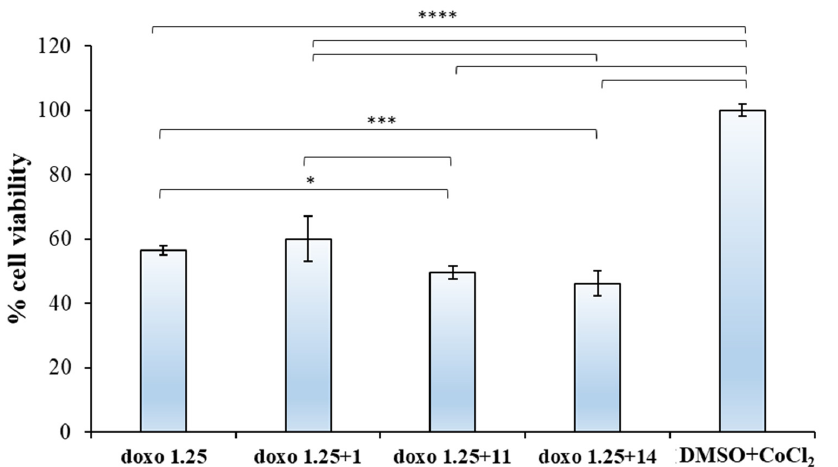
Figure 5. MTT assay on MCF7 cell line. Histogram represents the viability percentage of MCF7 cells exposed to doxorubicin 1.25 µM and to combinations of doxorubicin 1.25 µM with compounds 1 , 11 , and 14 , all administered at 100 µM for 72 h and under hypoxic conditions. Cell viability was measured by MTT assay and normalized to control cells treated with DMSO (0.1% as final concentration) + CoCl 2 100 µM. The most representative of three separate experiments is shown. Data are presented as the mean ± standard deviation. **** p < 0.0001; *** p < 0.001; * p < 0.1.